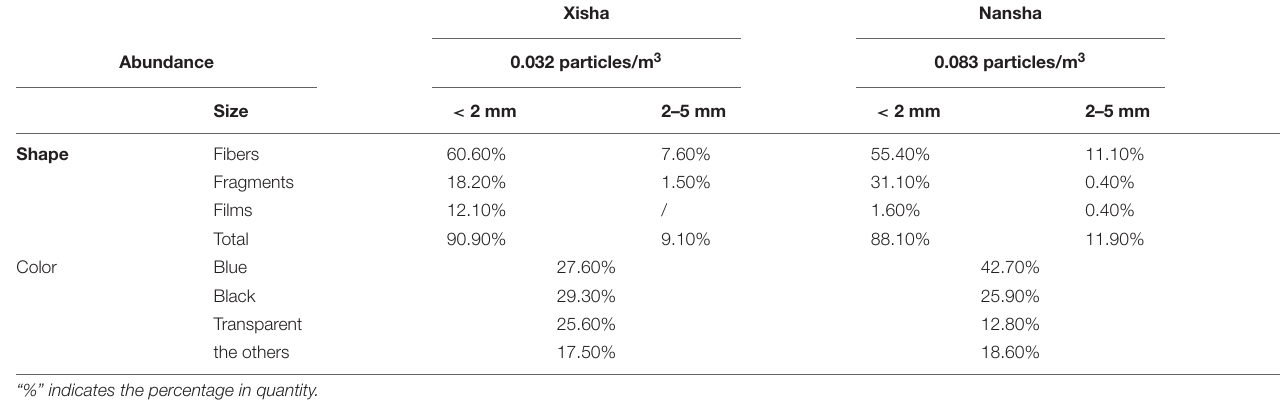
TABLE 1 | Comparison of the abundance and external morphological characteristics of microplastics (MPs) in Xisha Islands and Nansha Islands.